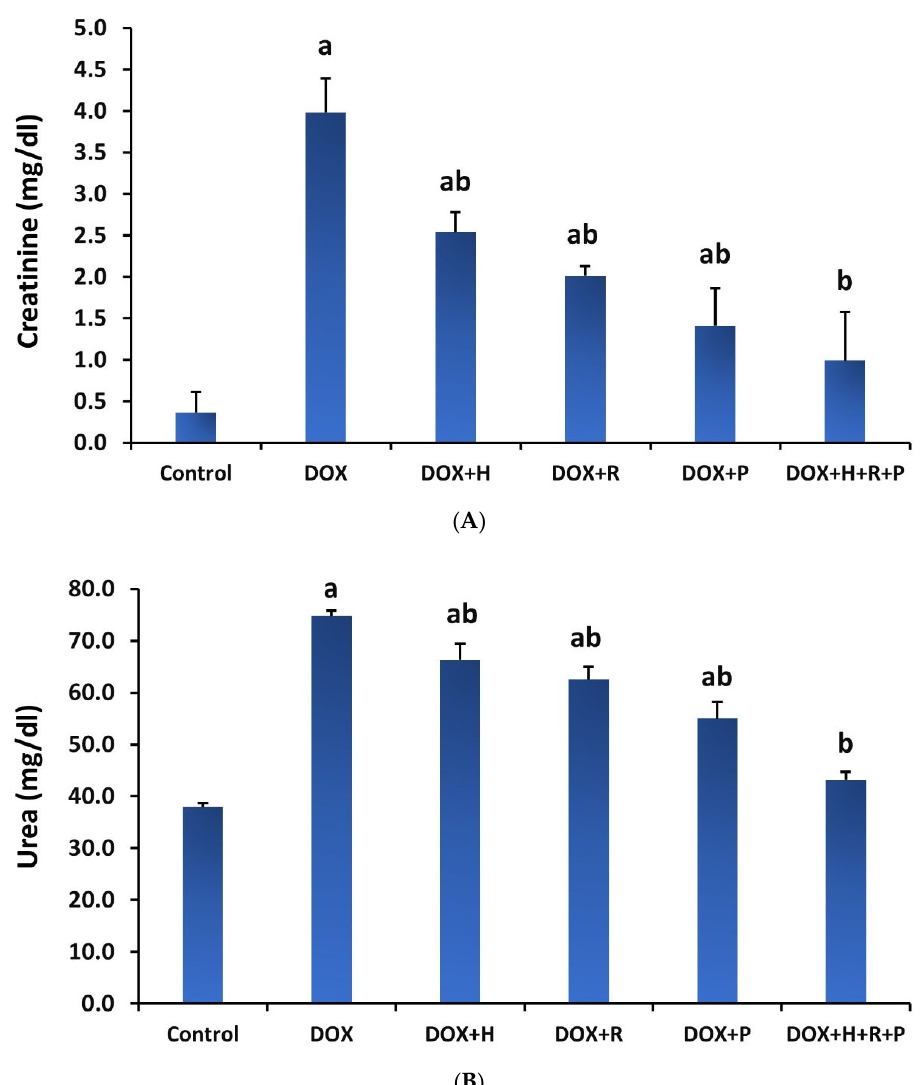
Figure 1. Effect of honey (H), royal jelly (R), and propolis (P) on the renal functions in rats treated with Doxorubicin, ( A ) creatinine, and ( B ) urea. Values are shown as mean ± SE. Different lowercase letters indicate significant differences compared to the corresponding value in the control group at p < 0.05.